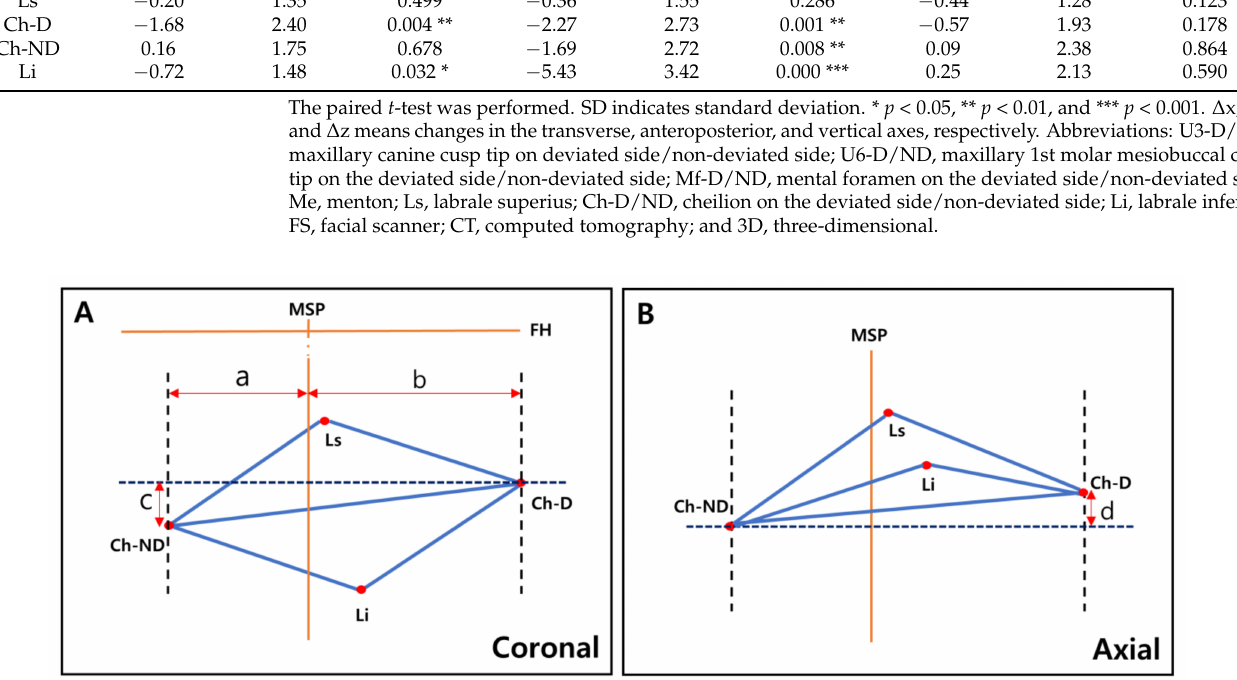
Figure 5. Schematic diagram of the upper and lower lip planes. ( A ) The coronal view of schematic diagram, ( B ) The axial view of schematic diagram. Abbreviations: MSP, midsagittal plane; FH, Frankfort horizontal plane; Ls, labrale superius; Ch-D/ND, cheilion on the deviated side/non- deviated side; Li, labrale inferius; b − a, transverse lip asymmetry; a + b, lip width; c, vertical lip asymmetry; and d, anteroposterior lip